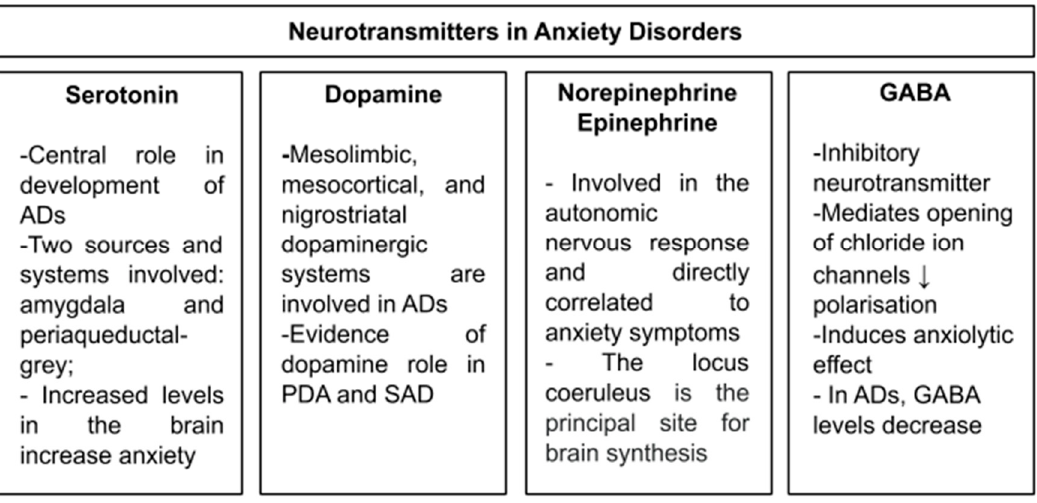
Figure 1. Neurotransmitters involved in anxiety disorders investigated in the present article. Note: ADs: anxiety disorders; GABA: gamma-aminobutyric acid; PDA: panic disorders with or without agoraphobia; SAD: social anxiety disorder.